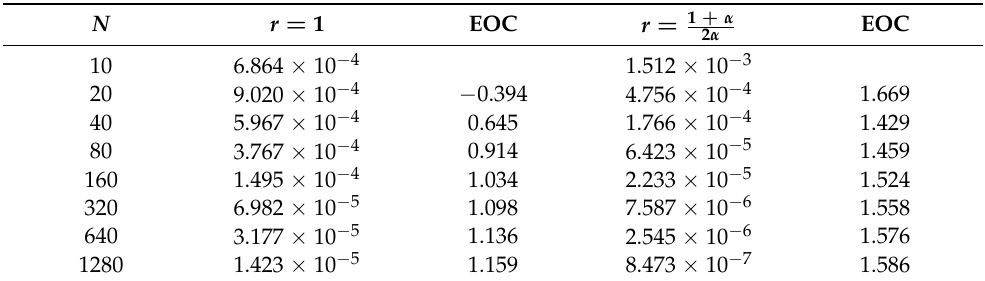
Table 6. Table showing the maximum absolute error and EOC for solving (27) using the predictor- corrector method for α = 0.6.